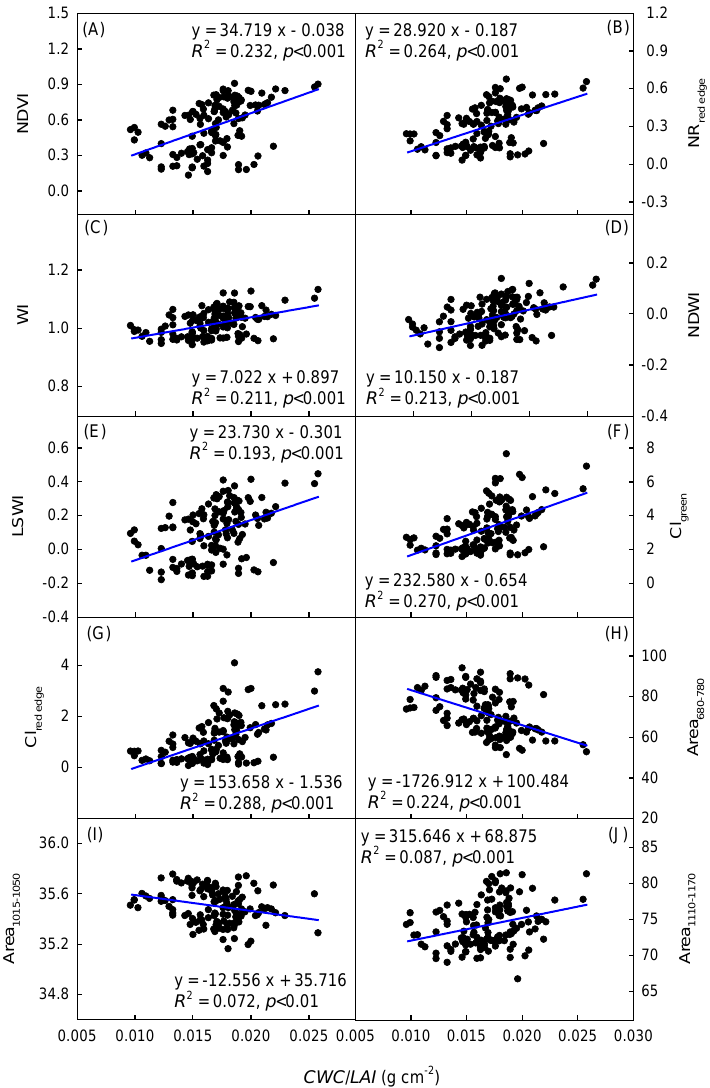
Figure 4. Relationships between ( A ) NDVI, ( B ) NR red edge , ( C ) WI, ( D ) NDWI, ( E ) LSWI, ( F ) CI green , ( G ) CI red edge , ( H ) Area 680–780 , ( I ) Area 1015–1050 , and ( J ) Area 1110–1170 vs. 𝐸𝑊𝑇̅̅̅̅̅̅̅ ( CWC / LAI ) for maize during the growing seasons of 2013–2014. Figures 2 and 3 provide the definitions of